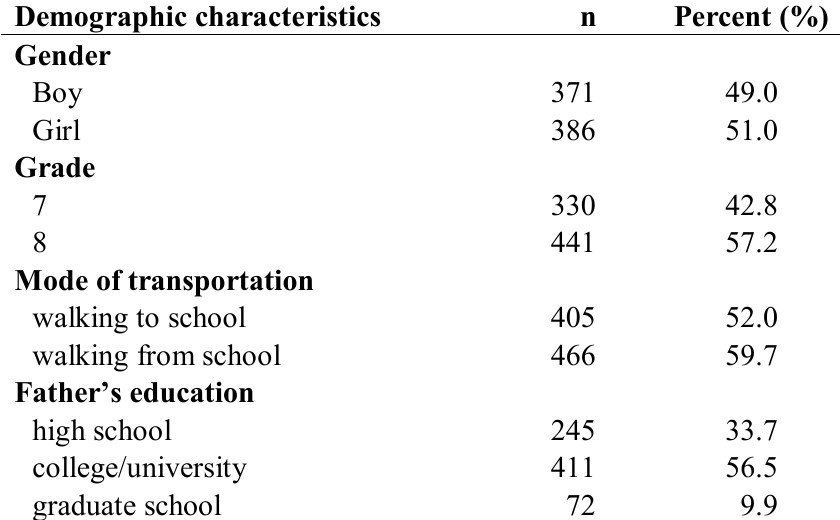
Table 1. Demographic characteristics of study subjects (n = 782)